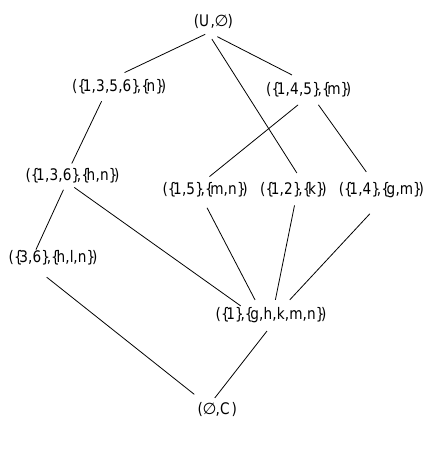
Fig.2. decision concept